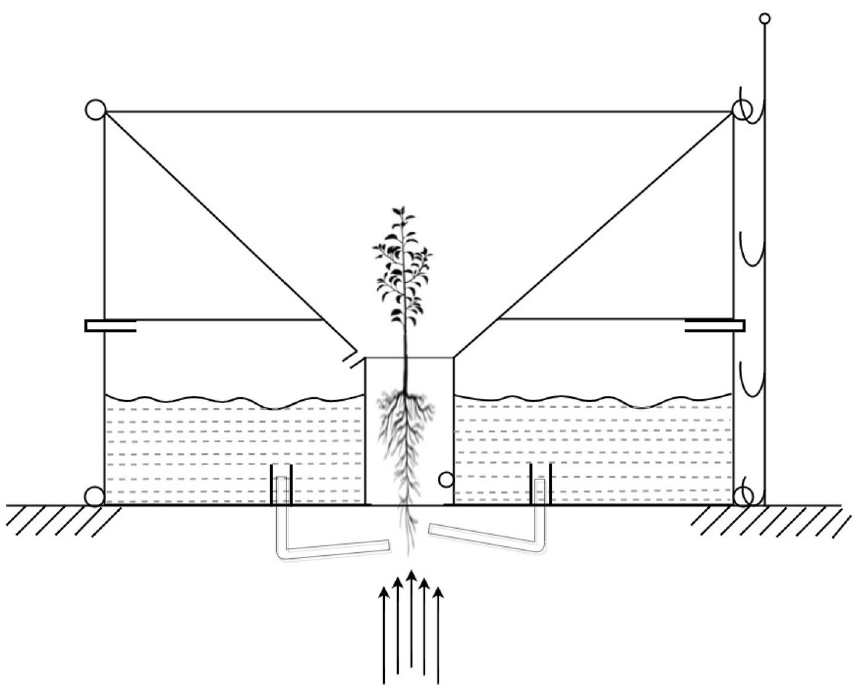
Figure 3. The original design of the WaterBoxx that the function analysis started with.